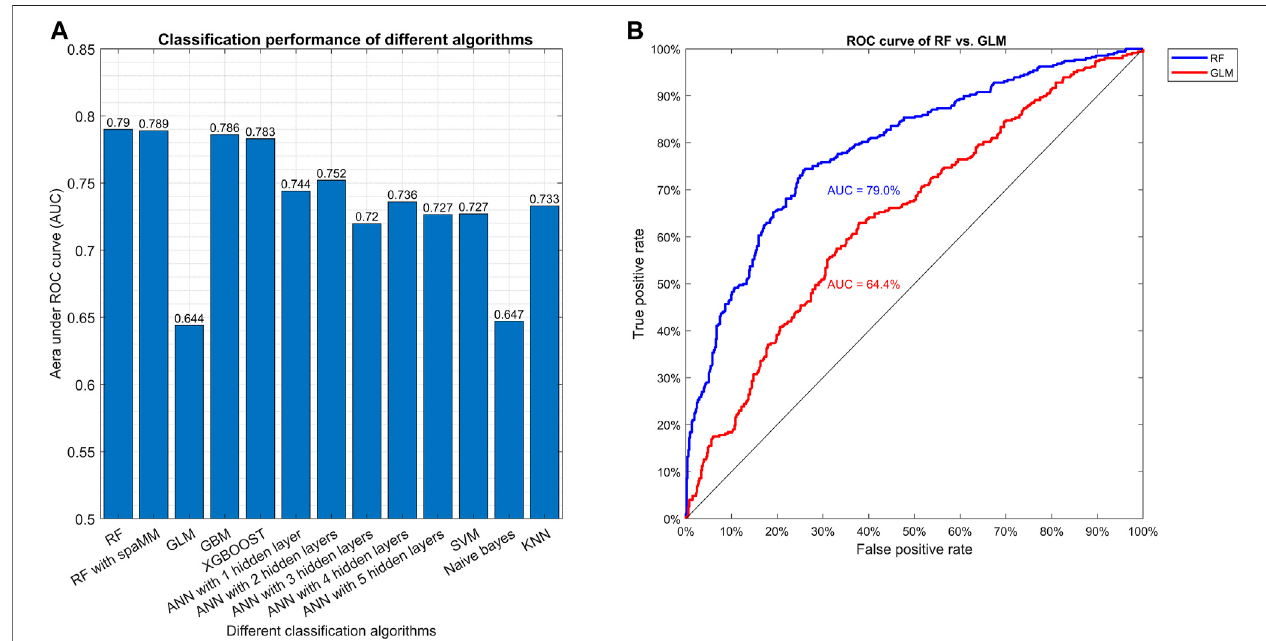
FIGURE 2 | Comparison of different classi fi cation algorithms based on AUC. Plot (A) shows the AUC in the fi nal testing step for the various algorithms after model tuning. Plot (B) shows the ROC curve of the best (RF) and the worst (GLM) algorithms.